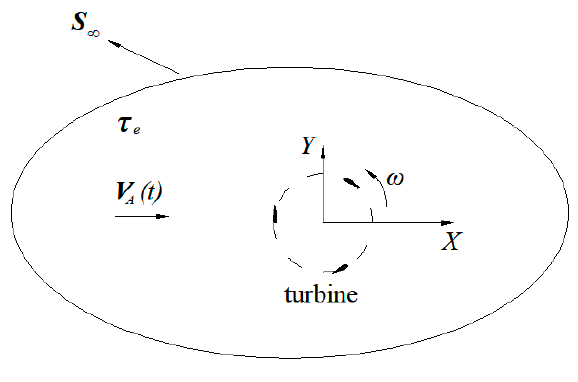
Figure 1. The flow Figure 1. The flow domain.